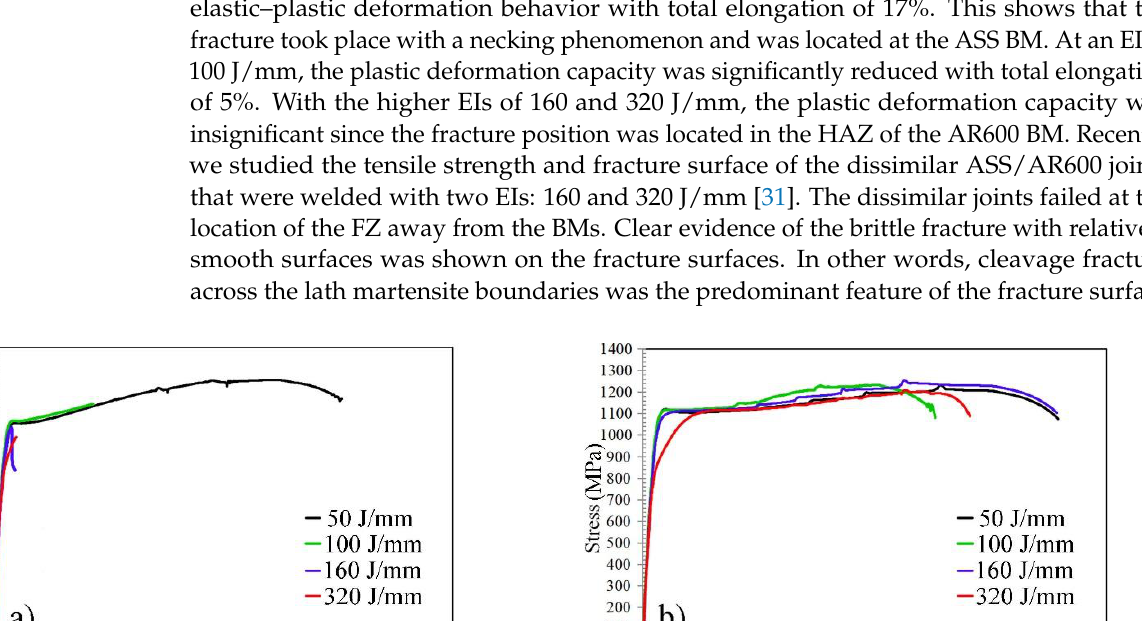
Figure 13. Macrograph images of the tensile samples of the dissimilar joints after testing showing the fraction positions in the post-weld joints that were heat-treated at 250 °C. 4. Conclusions In this study, ultra-high-strength steels, i.e., 1.3 GPa strength cold-hardened austen- itic stainless steel AISI 301 (ASS) and 2.2 GPa strength martensitic abrasion-resistant steel AR600, were welded using laser welding with different energy inputs (EIs) (50 – 320 J/mm). The microstructure and mechanical properties of the dissimilar butt joints were studied; the main conclusions are as follows: (1) Sound dissimilar welded joints of 301ASS/AR600 laser welding were manufac- tured with no severe welding defects, such as pores and microcracks, formed in the fusion zone. The microstructure of the FZ was composed of lath martensite and a small fraction of austenite. (2) The average microhardness of the welded joint decreased with increasing the en- ergy input from 640 HV at an EI of 50 J/mm to 520 HV at an EI of 320 J/mm. Furthermore, the microhardness in the fusion zone was relatively nonuniform due to the coexistence of the soft phase  -fcc within the hard martensitic α  - bct matrix.